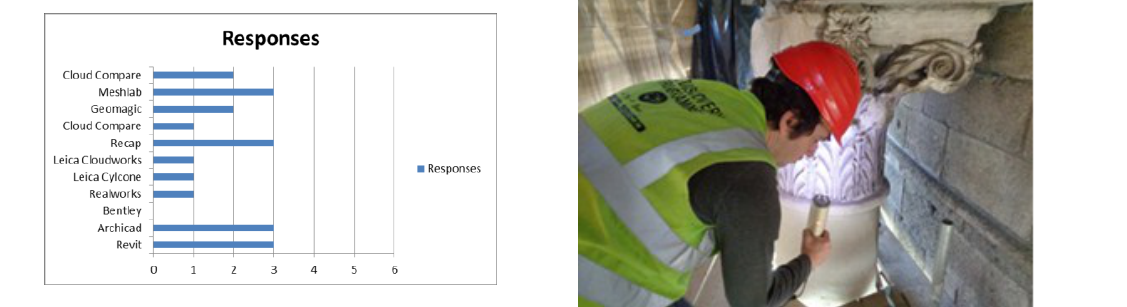
Figure 6: Higher Resolution Point Cloud from